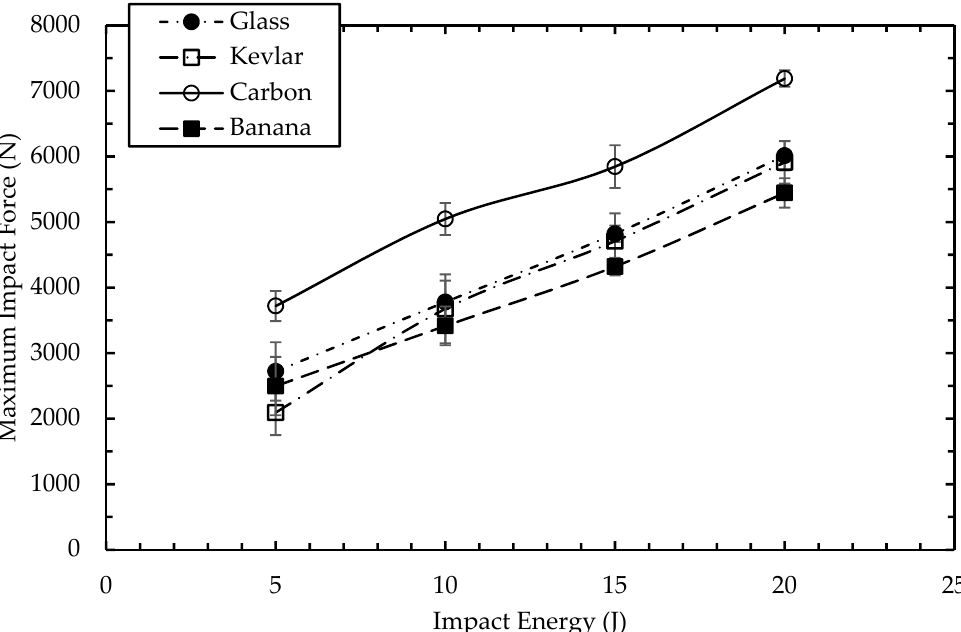
Figure 6. The variation of the maximum impact force at different impact energy levels for composite structures.